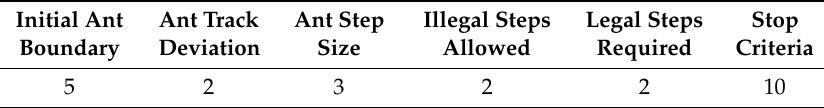
Table 2. The ant tracking parameters used in this